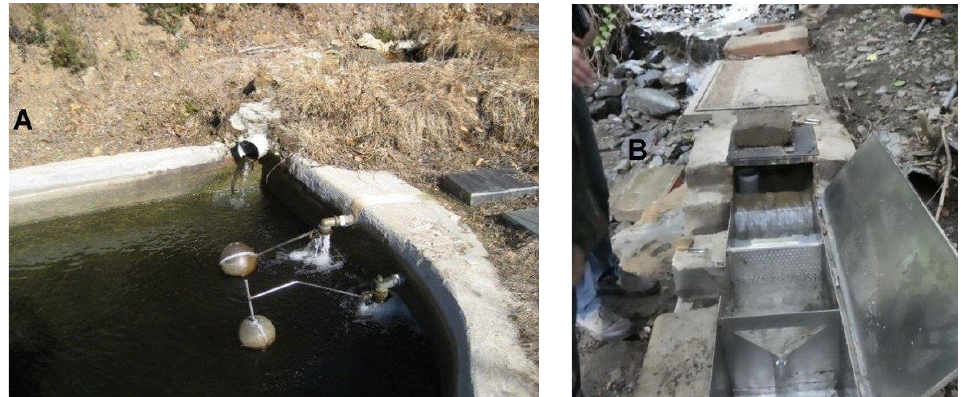
Figure 12. Installed mechanisms which regulate water extraction ( A ) and distribution boxes ( B ) re- stricting the amount of legally allowed water for exploitation.